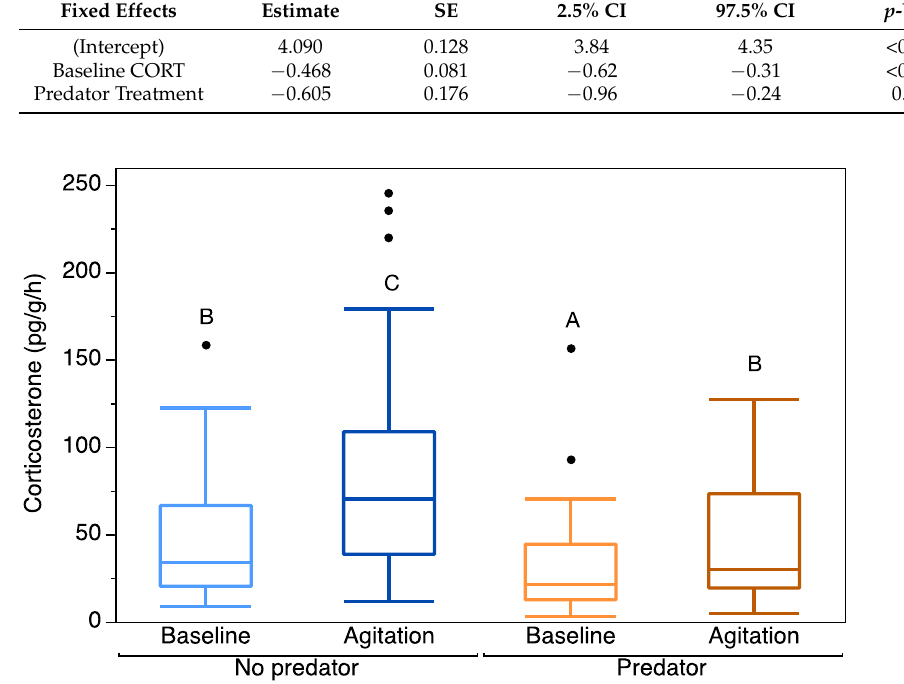
Figure 1. Mean baseline and agitation corticosterone release rates (pg/g/h) (untransformed) for individuals from stream reaches without fish predators and with fish predators. Box plots indicate median, range, and first and third quartiles. Points indicate outliers. Letters indicate significant differences in CORT release rates between combinations of fixed factors.